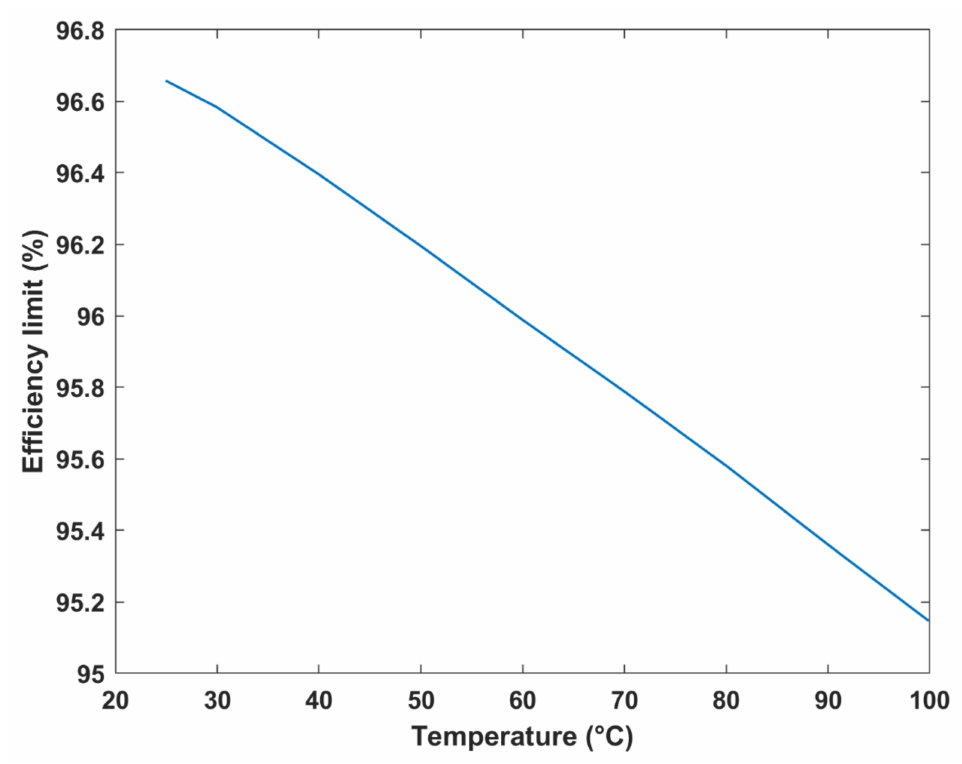
Figure 11. Maximum efficiency vs.